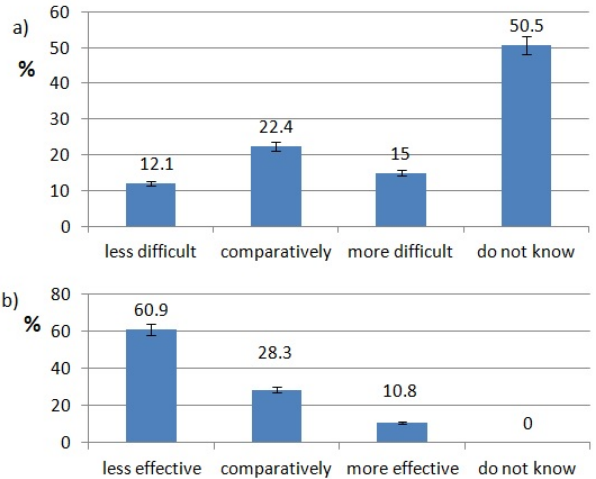
Figure 4. Air abrasion use pattern of responding dentists; ( a ) difficulty of air abrasion procedures, ( b ) effectiveness of air abrasion procedures.